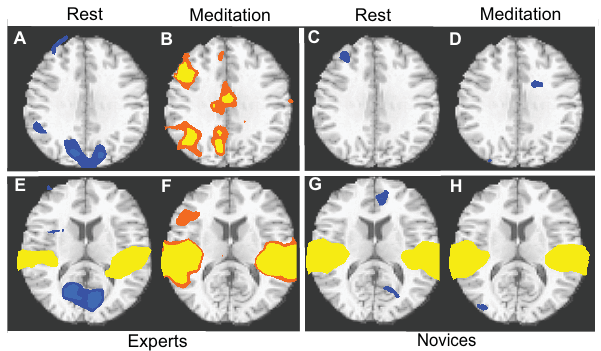
Figure 4. Directionality of the brain activation. Areas showing a negative ( dark blue, p , 0.01, blue, p , 0.005) or positive (orange, p , 0.01, yellow, p , 0.005) impulse response on average across 10 seconds in responses to all emotional sounds for the 15 novices and 15 experts at z=31 compared to baseline (figs. A–D) and z=13 (figs. E–H) (voxel-by-voxel paired t test compared to 0, corrected at p , 0.01).